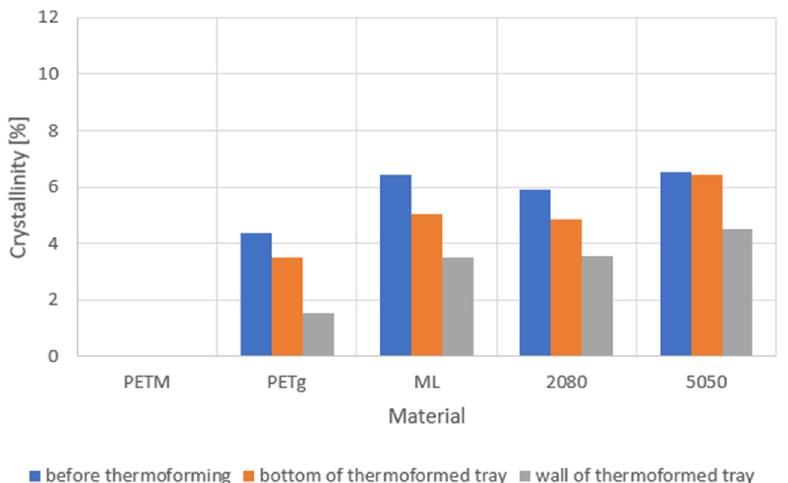
Figure 9. Crystallinity of the sheets and multilayer sheets (Table 2) before (blue) and after the ther- moforming process for the samples taken in the bottom (orange) and in the wall (gray) of the tray.